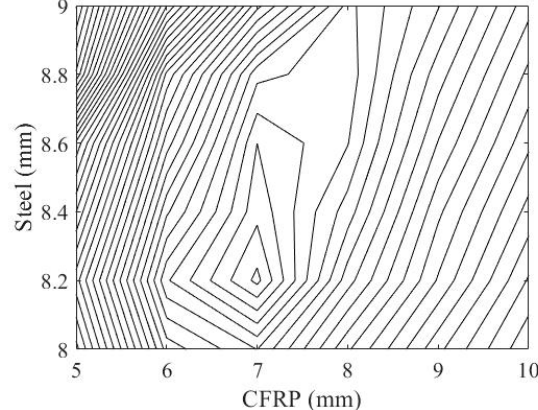
Figure 13. Contour plot of the objective surface in Figure 12.